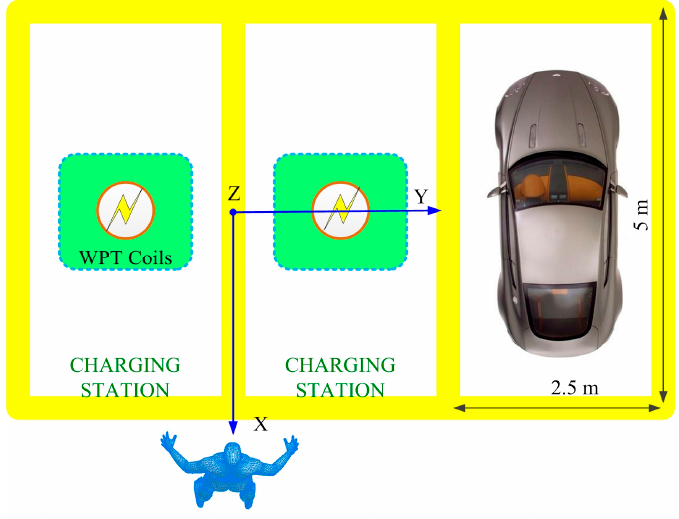
Figure 3. WPT systems for electric vehicle charging.